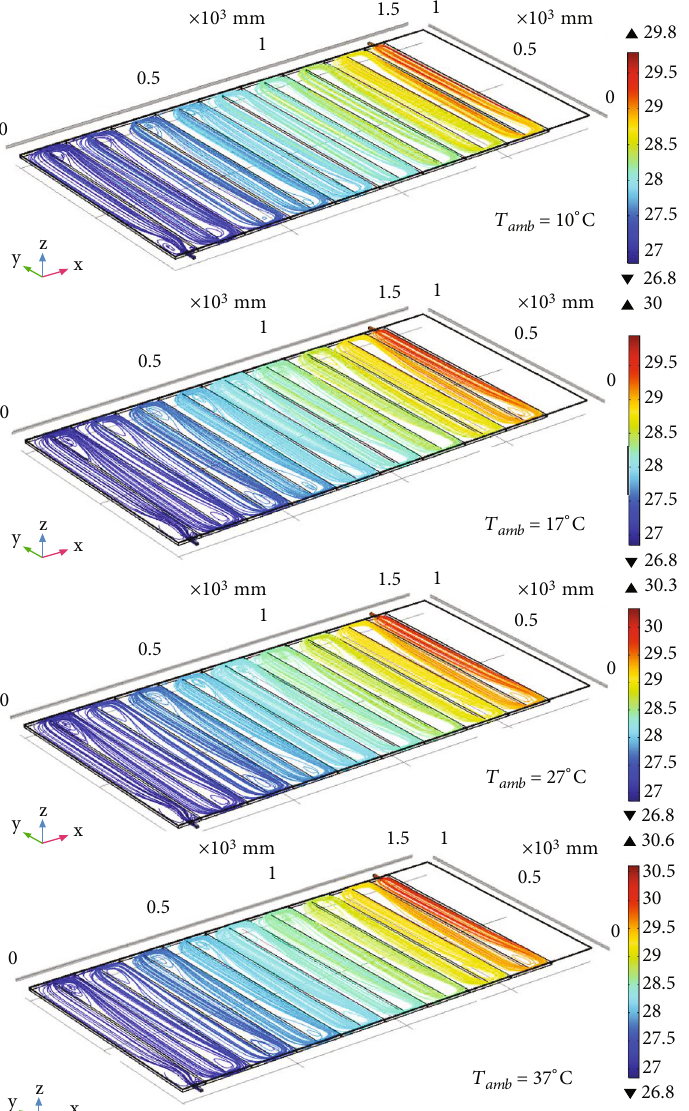
Figure 9: Outcome of ambient temperature on PVT streamlines plot with G = 500 W/m 2 , V